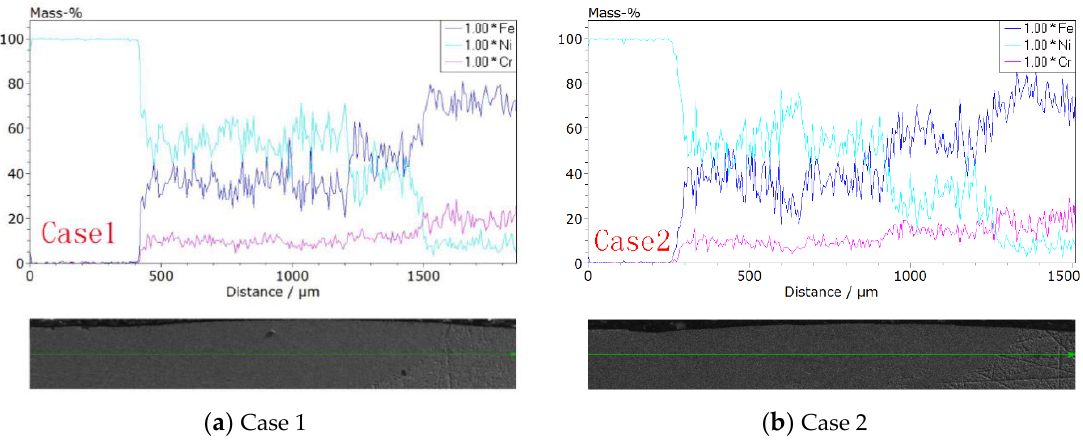
Figure 13. Element distribution under different heat input. ( a ) 80 J/mm, ( b ) 40 J/mm.